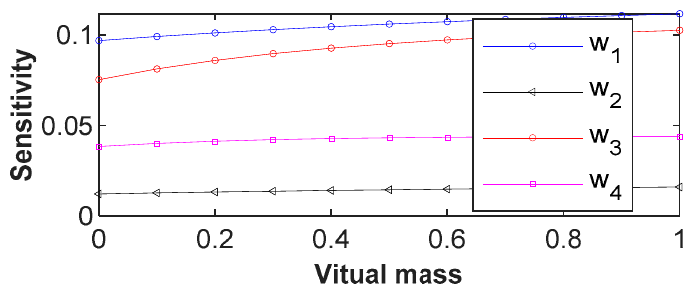
Figure 2. Relative sensitivity of first fourth-order frequencies with virtual mass in substructure 5.